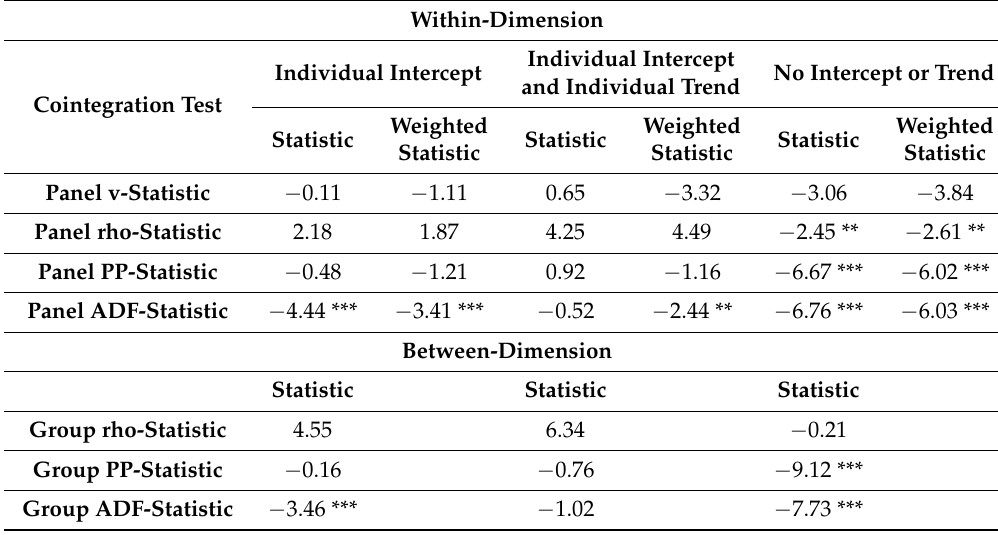
Table 9. Pedroni (Engle Granger based) test results.